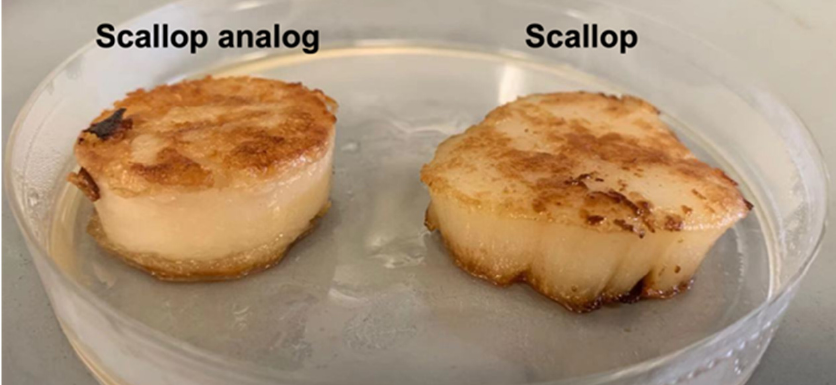
Figure 7. Scallop and scallop analog after grilling. The scallop analogs contained 10% pea protein, 0.5% pectin, and 2% transglutaminase. Table 1. Colorimetric analysis of scallops and scallop analogs after grilling. The scallop analogs contained 10% pea protein, 0.5% pectin, and 2% transglutaminase. Error bars represent the standard errors ( n = 3), and similar letters mean no statistical difference between treatments ( p ≤ 0.05).